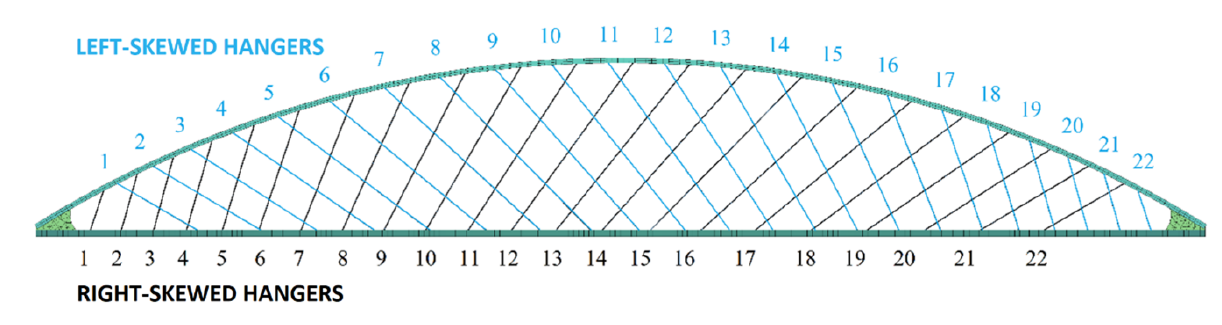
Figure 20: The numeration scheme of hangers’